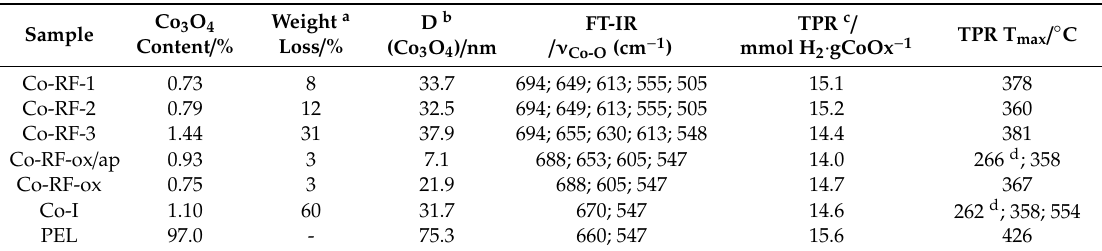
Table 1. Characteristic data of the catalysts examined by XRD, FTIR, and temperature programmed reduction